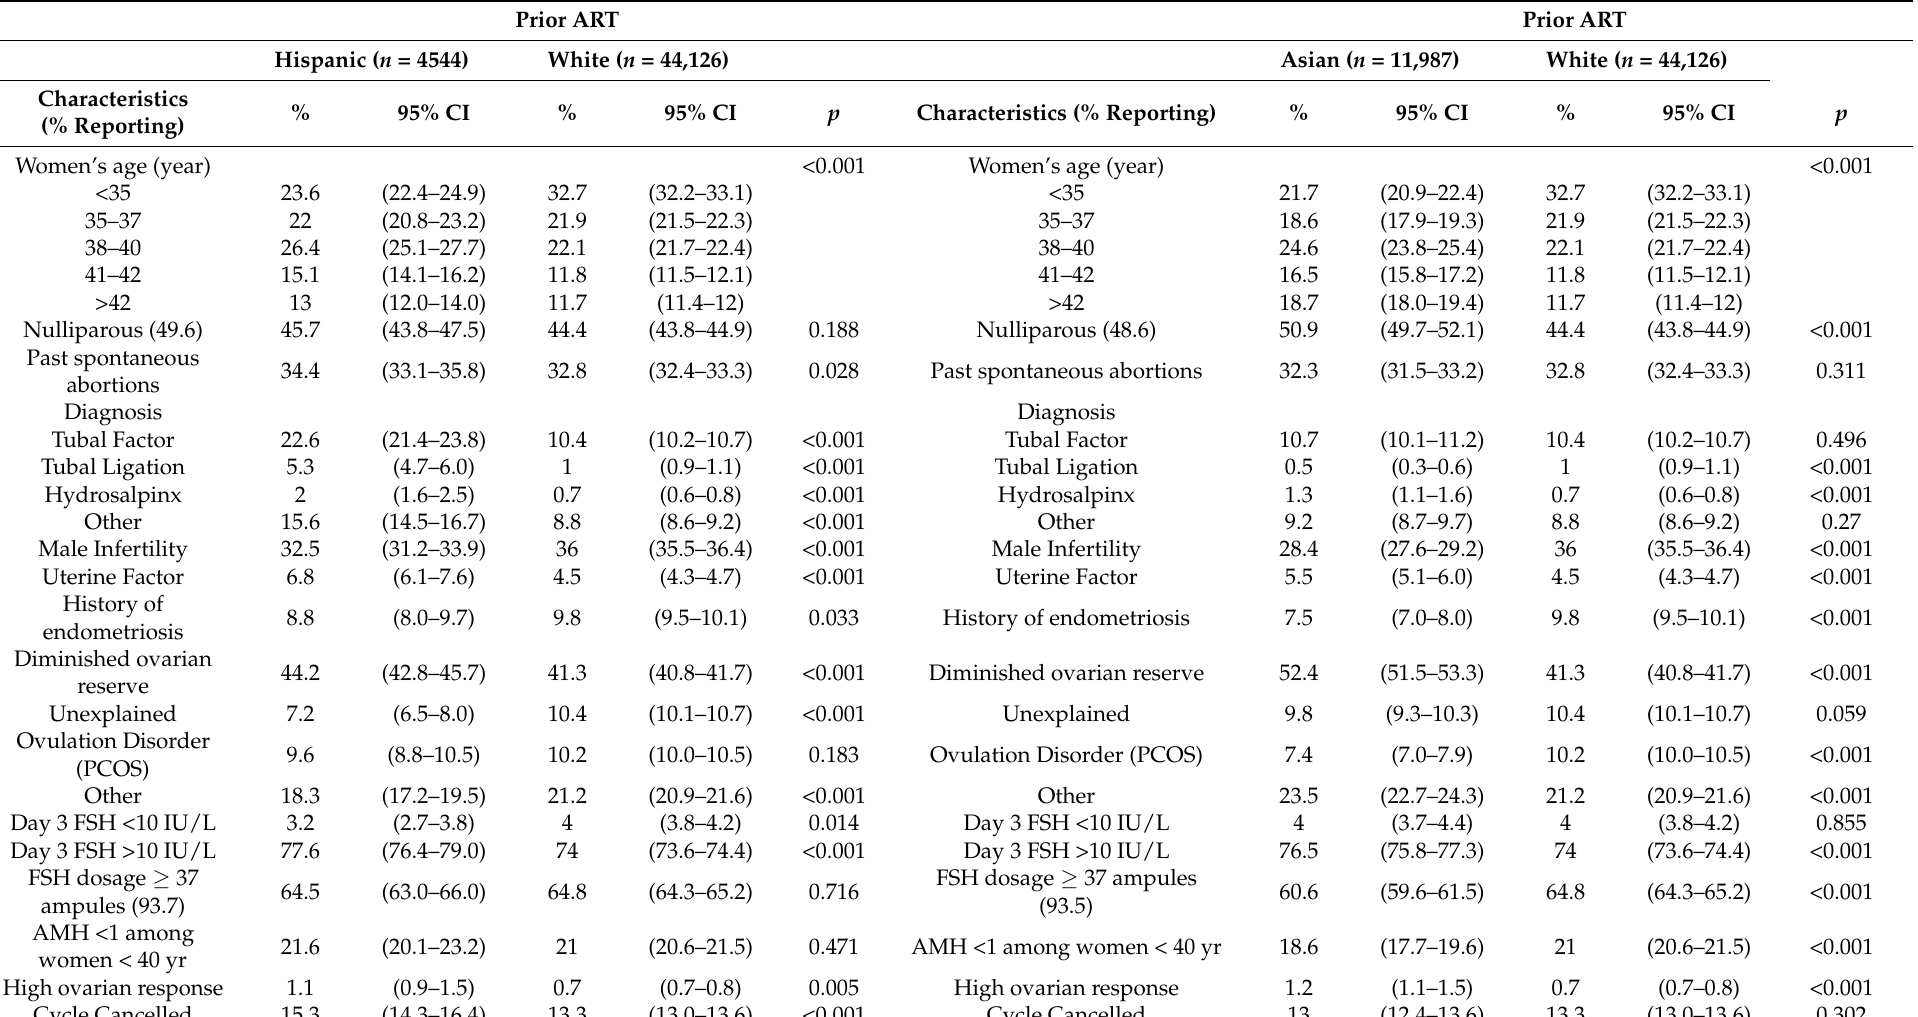
Table 2. Baseline characteristics, treatment, and outcomes for fresh, nondonor cycles among Hispanic, Asian, and WNH women with prior